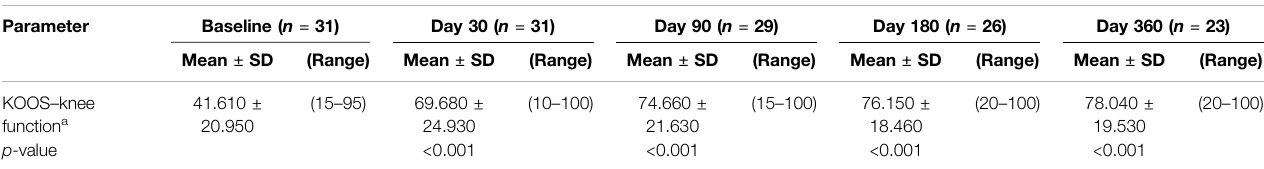
TABLE 1 | Primary ef fi cacy endpoint analysis. Statistical signi fi cance refers to comparison with baseline.